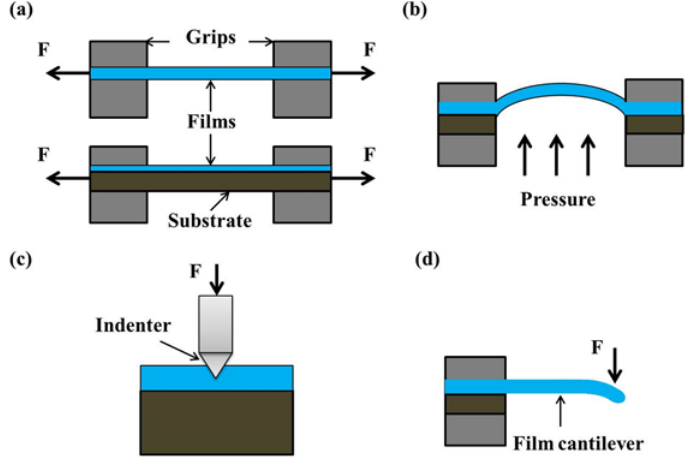
Figure 8. Methods for mechanical characterizing of thin films from the response to the applied stresses [5]: ( a ) tensile testing; ( b ) bulge testing; ( c ) indentation (micro or nano) hardness testing; ( d ) deflection of